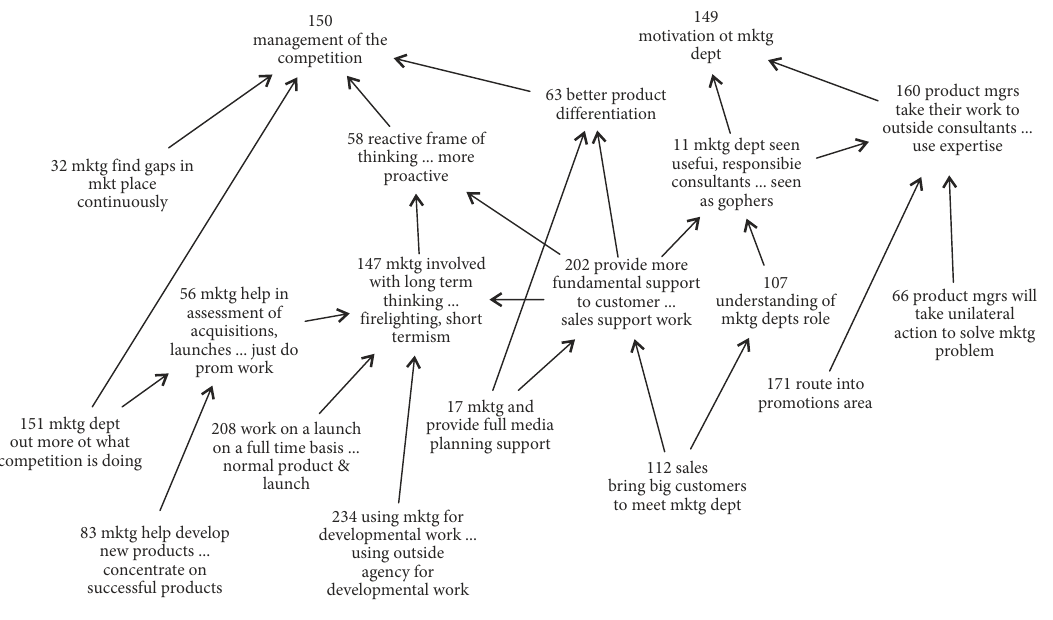
Figure 1. Example of a cognitive map [partial